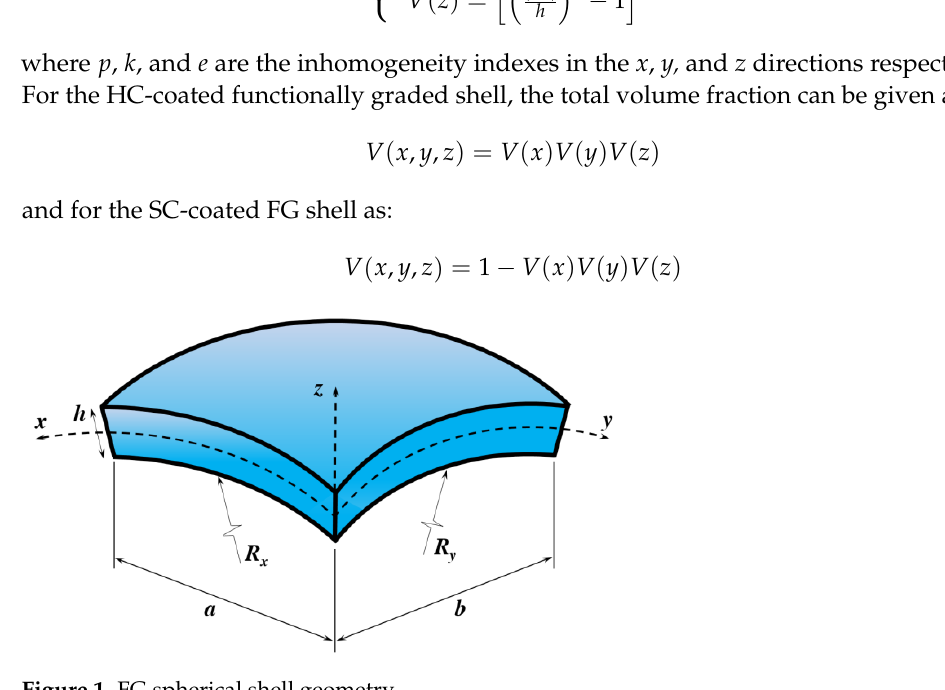
Figure 2. Five schemes of coated FG shell (𝑅 𝑥 = 𝑅 𝑦 = ∞) . Figure 3. Functionally graded material distribution. 3. Basic Equations 3.1. Generalized Higher-Order Shear Deformation Theory The displacement field is based on the classical generalized higher-order shear de- formation theory (HSDT), which contains five displacements variables that can be given by [4]: